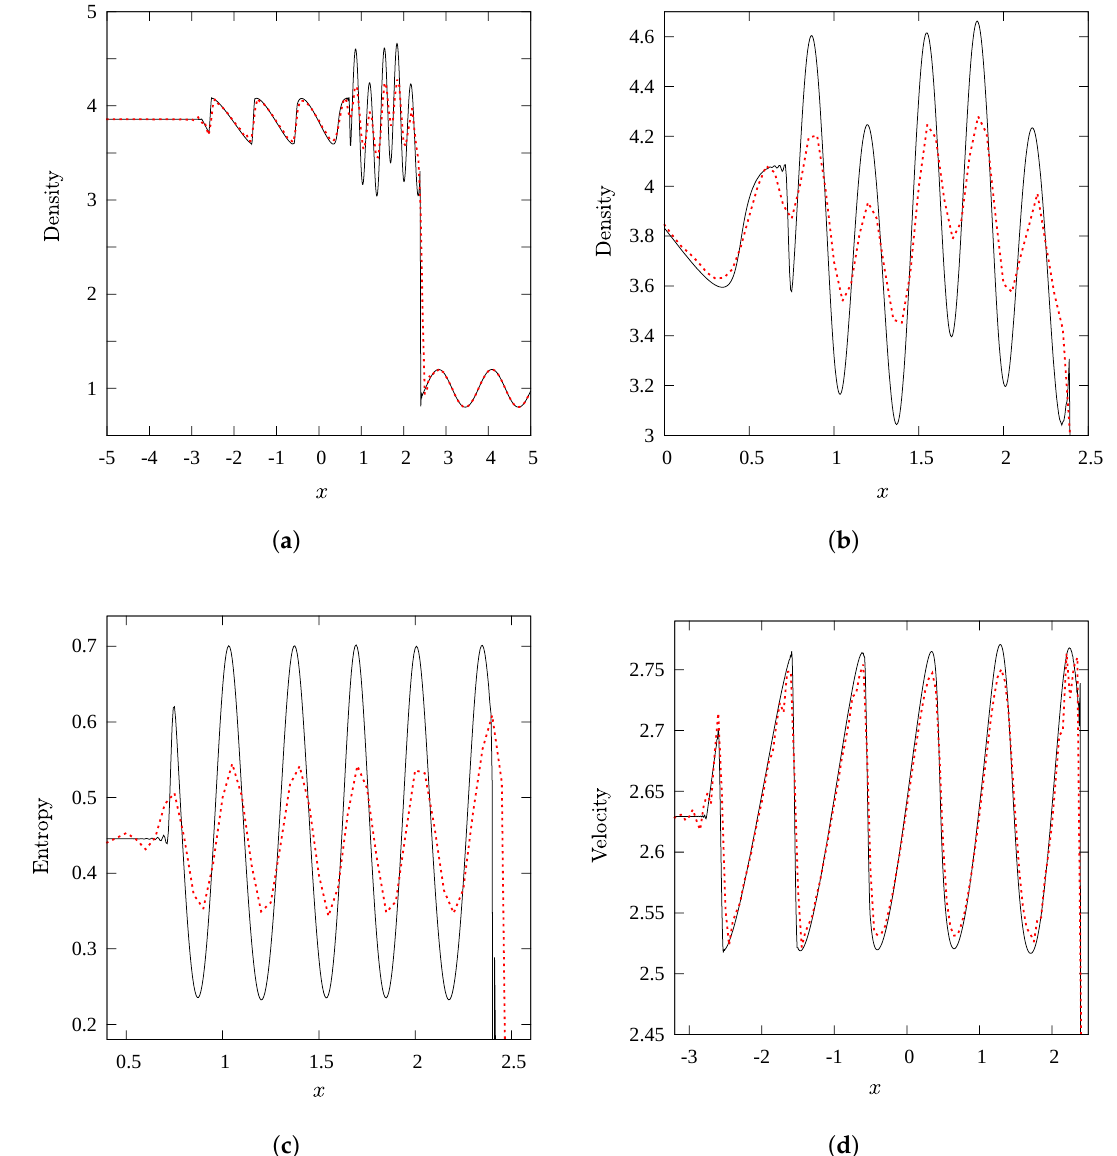
Figure 6. Shu–Osher problem at t = 1.8 (red dotted curve: ∆ x = 0.05; black curve: ∆ x = 6.25 × 10 − 3